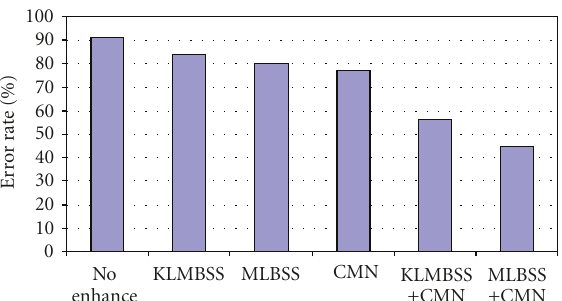
Figure 7: Error rate (%) of the Nevisa system in isolated command recognition operational mode on data recorded in real environment versus di ff erent combinations of the proposed MLBSS algorithm, KLMBSS, and